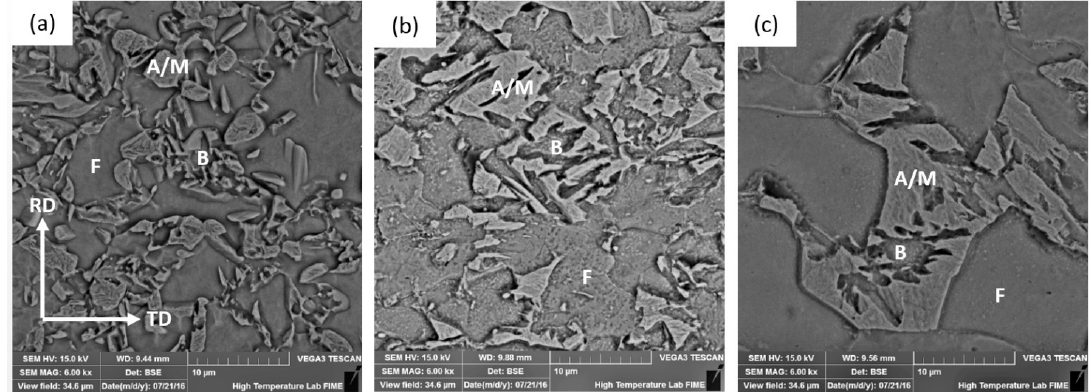
Figure 4. SEM micrographs of representative samples of each steel: ( a ) F/P, ( b ) HA900, ( c ) HA1100. A/M: Austenite/Martensite, F: Ferrite, B: Bainite [28].